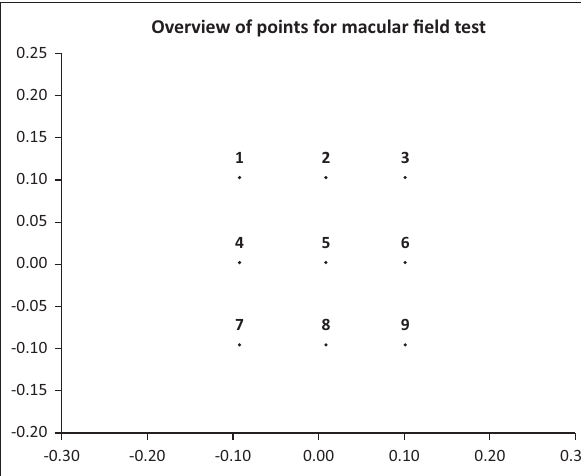
FIGURE 1: Schematic diagram of macular oscillatory sensitivity field test with the nine points. The foveal point (0.0; 0.0) is portrayed by Point 5. As can be seen by the grid, Points 1 to 9 have the following coordinates: (-0.10; 0.10), (0; 0.10), (0.10; 0.10), (-0.10; 0.0), (0.0; 0.0), (0.1; 0.0), (-0.10; -0.10), (0.0; -0.10) and (0.10; -0.10),